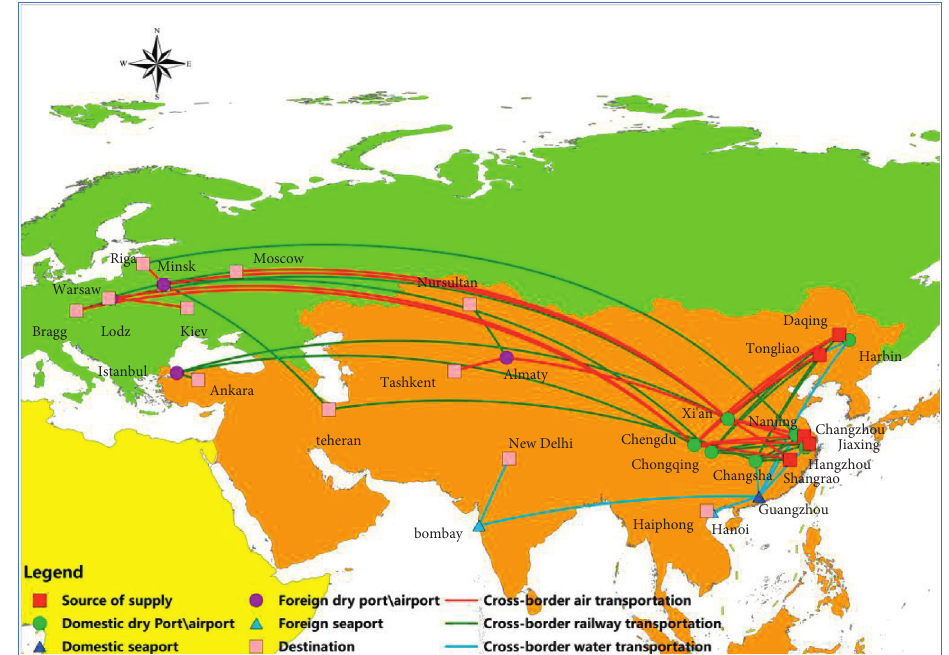
Figure 10: The optimal cross-border logistics paths in northeast and southeast regions.